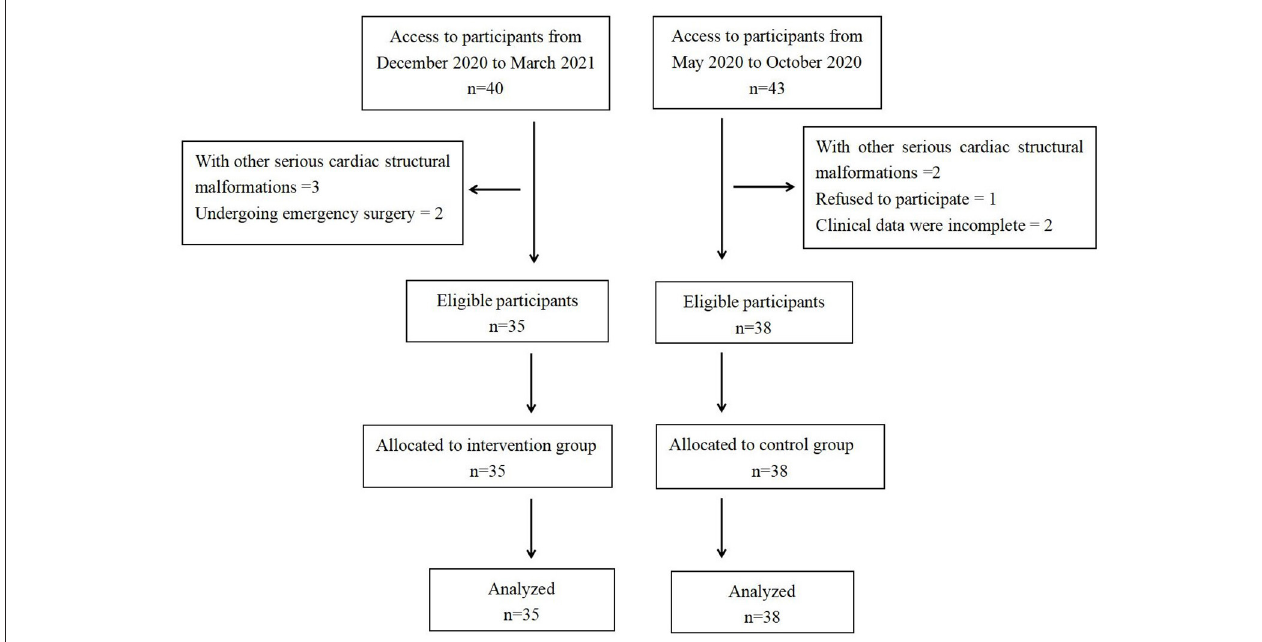
FIGURE 1 | The frame of the